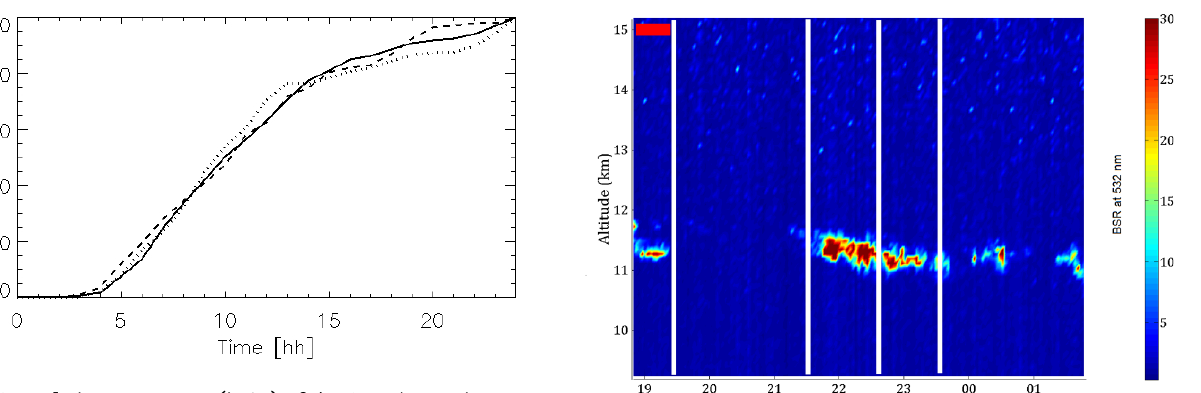
Fig. 1. Cumulative occurrence (in %) of the OHP/RTV air mass coincidence in function of the time spent by the air masses (at 8, 10 Fig. 2a. Contour plot of the backscattering ratio (BSR) calculated and 12km; solid, dashed and dotted lines, respectively) to go from from the elastic channel at 532nm for the lidar session at OHP OHP to RTV sites. Backward trajectories have been computed for between 18:48 and 01:44UTC. White vertical lines identify the the 5-yr period (2006–2010). quasi-stationary periods. The horizontal red bar indicates the quasi- stationary period used in the Match approach Table 2. Night-time lidar sessions, common days of measurements and Match sessions acquired during the period 2007–2008 by the OHP and RTV lidar systems. Common Match 2007–2008 OHP RTV days sessions